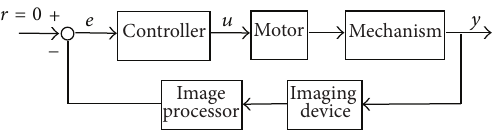
Figure 1: Closed loop control